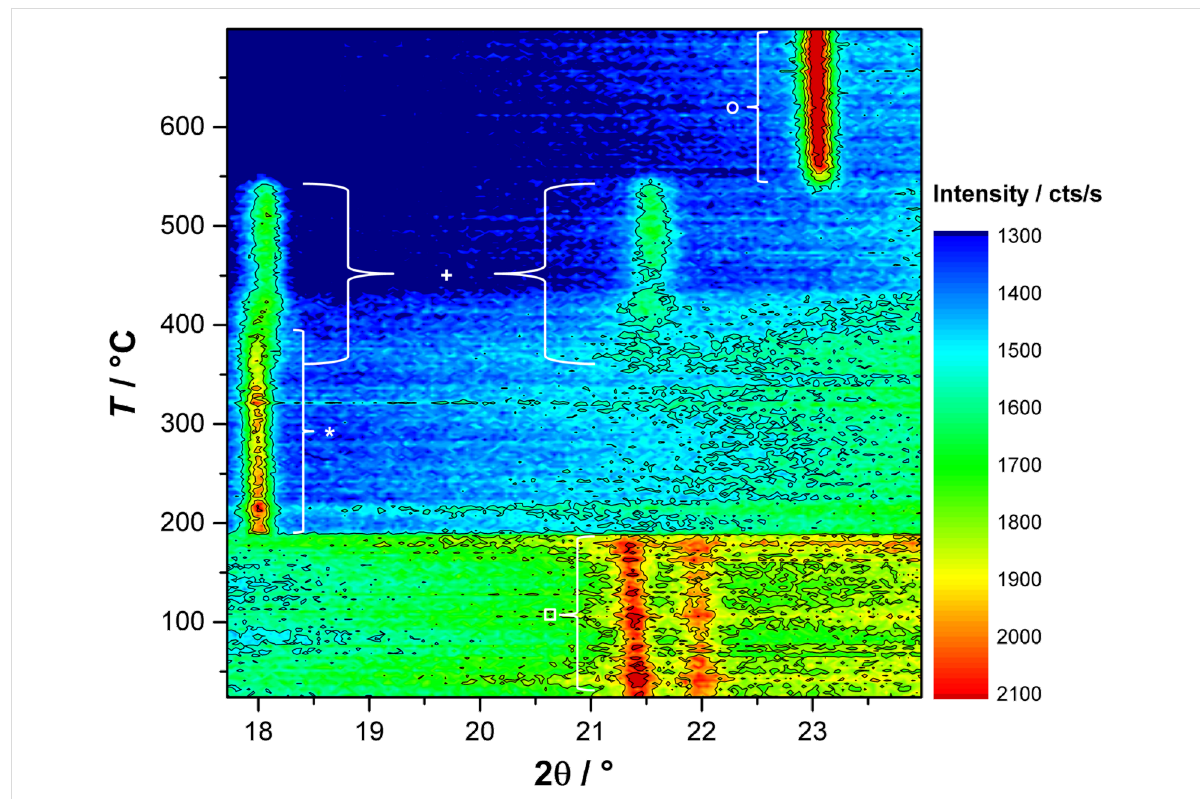
Figure 3: In situ XRD patterns recorded in a pure O 2 flow while heating the Mn(II) glycolate precursor to 700 °C at 2 K/min; reflexes denoted are: Mn(II) glycolate ( □ ), Mn 3 O 4 ( * ), Mn 5 O 8 (+) and α -Mn 2 O 3 ( ○ ).